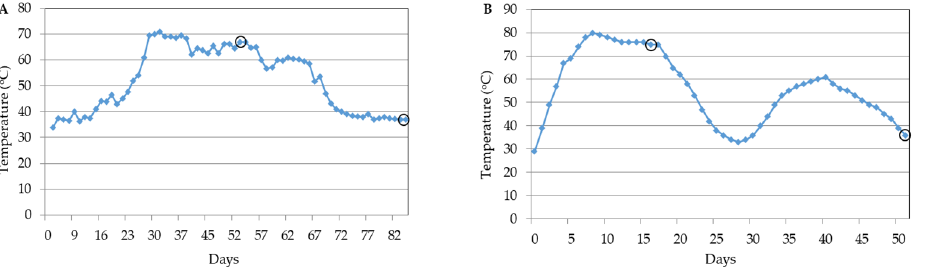
Figure 1. Temperature changes during the composting process at Harmanli ( A ) and at Yasno pole ( B ) sites. In both figures, the sampling times are indicated—thermophilic and mesophilic. The rest of the physicochemical parameters of compost during thermophilic and